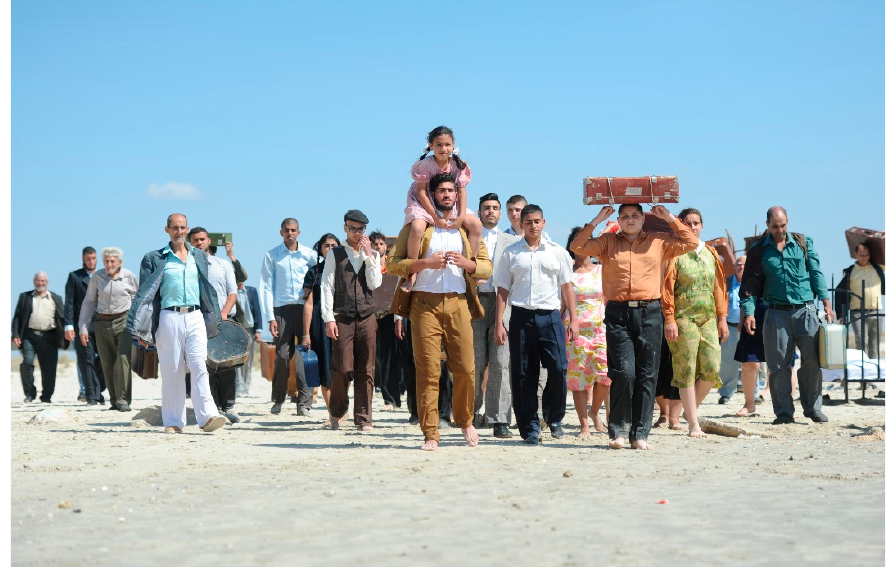
Figure 3. Raida Adon, Strangeness , 2018, Video, 33:30 mins. © Tami Weiss